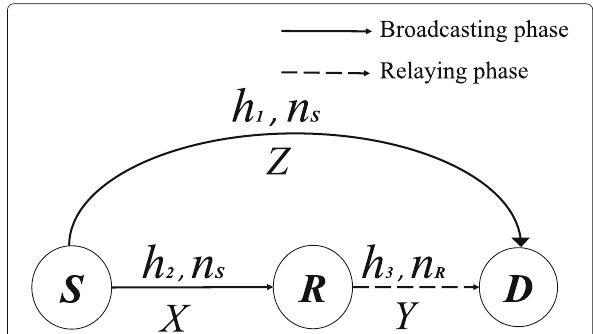
Fig. 1 System model for relaying with a source, destination, and a decode-forward relay. This figure illustrates the system model for cooperative decode-and-forward relaying scenario including a source, a relay, and a destination. The links between S to D , S to R , and R to D are referred as the direct link h 1 , broadcasting link h 2 and relaying link h 3 each of which with n i channel uses respectively, where i ∈ { S , R